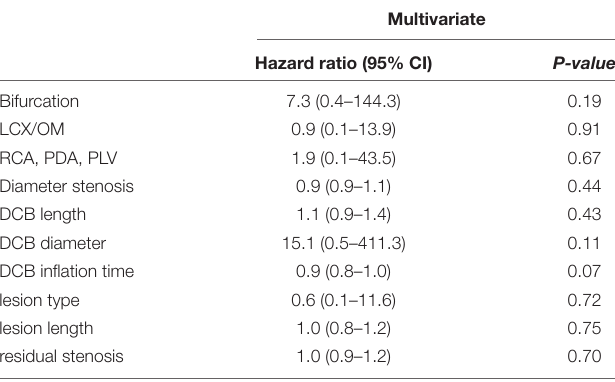
TABLE 5 | Cox regression analysis of target lesion failure